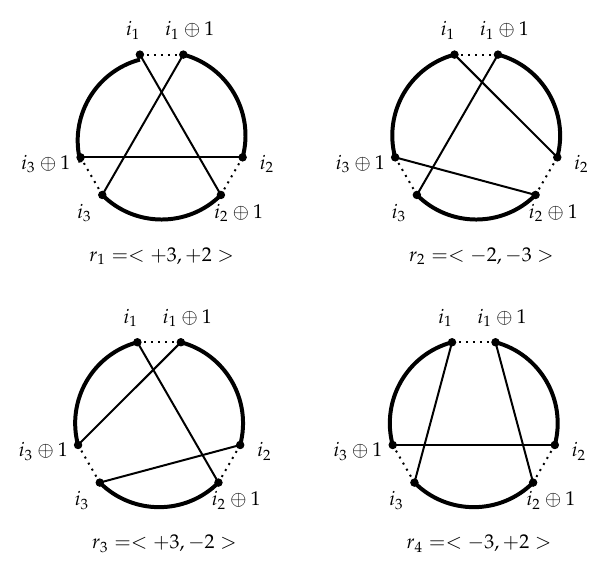
Figure 1. The pure reinsertion schemes of